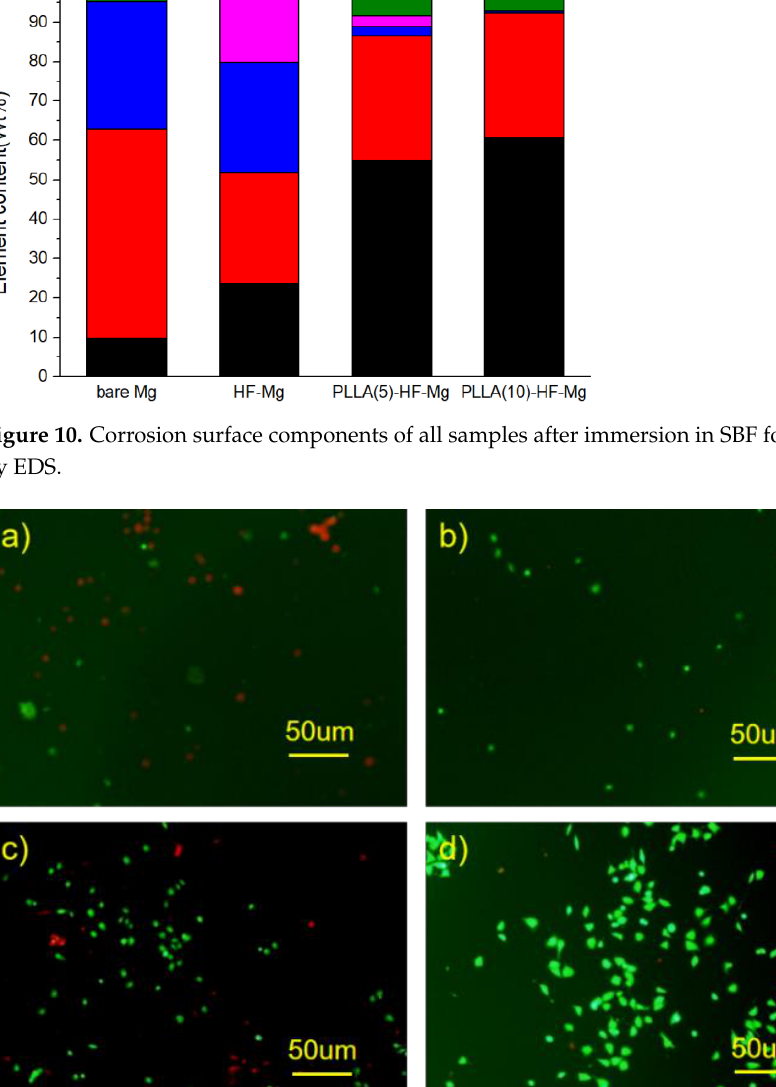
Figure 10. Corrosion surface components of all samples after immersion in SBF for 15 days analyzed by EDS.